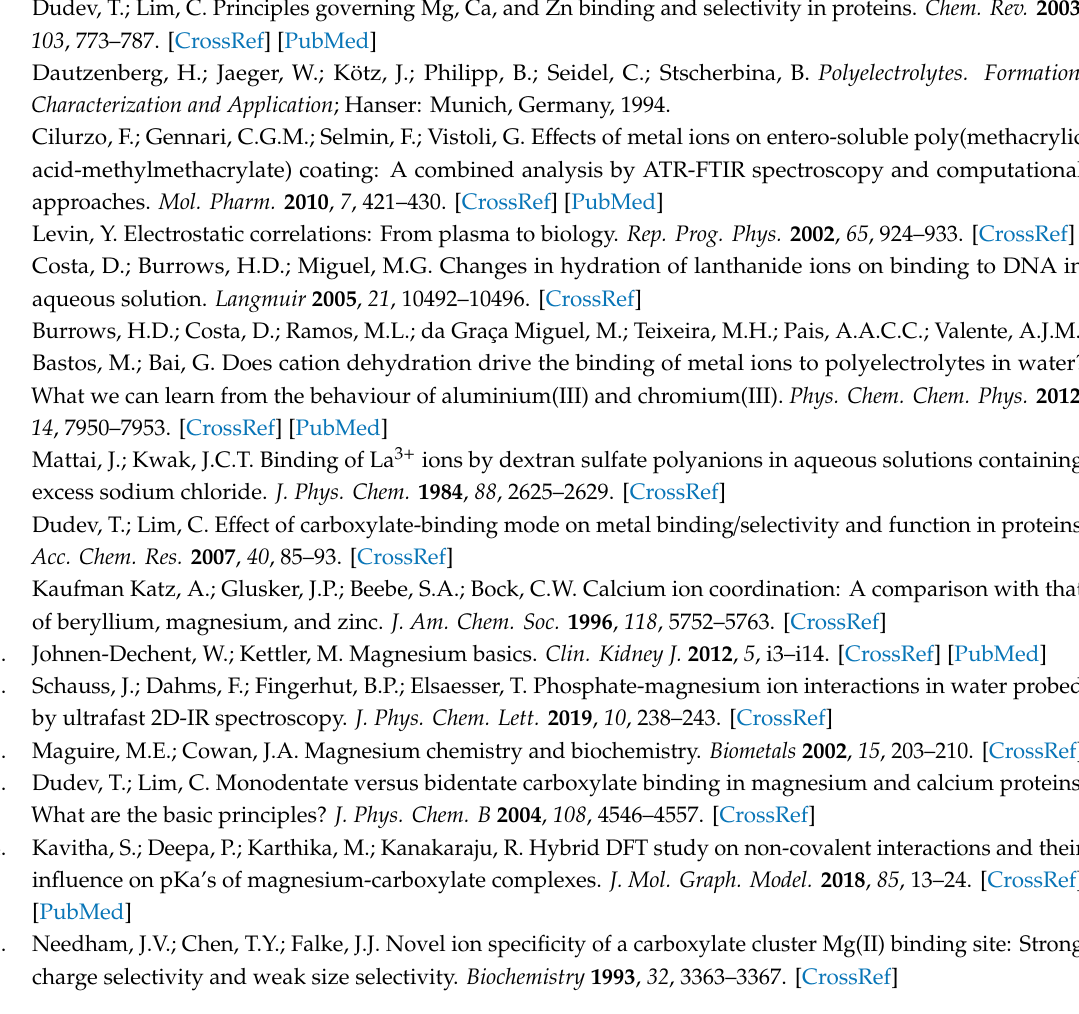
Scheme S1: Schematic presentation of monodentate binding of COO − to Mg 2 + , Scheme S2: A typical structure of a micro-gel like particle, Figure S1: The distribution of hydrodynamic radii ( R h ) of particles obtained in i- and aPMA solution in the presence of Mg 2 + , Figure S2: Examples of R h,ass determination for i- and aPMA associates in MgCl 2 solution, Figure S3: Examples of the Debye-Bueche plots for R g,ass determination for i- and aPMA associates in MgCl 2 solution, Figure S4: Ionization enthalpies of i- and aPMA in solutions of MgCl 2 and LaCl 3 with I = 0.1 mol · L − 1 , Table S1: Hydrodynamic radii for smaller particles ( R h,1 ) and associates ( R h,ass ), radii of gyration (R g,ass ) and parameter ρ in iPMA solutions in the presence of NaCl, MgCl 2 and LaCl 3 at di ff erent I , Table S2: Hydrodynamic radii for smaller particles ( R h,1 , R h,2 ) and associates ( R h,ass ), radii of gyration (R g,ass ) and parameter ρ in aPMA solutions in the presence of NaCl, MgCl 2 and LaCl 3 at di ff erent I , Table S3: The measured pH and calculated α i values for i- and aPMA in aqueous NaCl, MgCl 2 and LaCl 3 with di ff erent I . Author Contributions: K.K. conceived the idea and carried out the calorimetric measurements, while P.H. did all the other experimental work and wrote the paper draft. K.K. is thanked for helping in the interpretation of the data and for support at revising and writing the